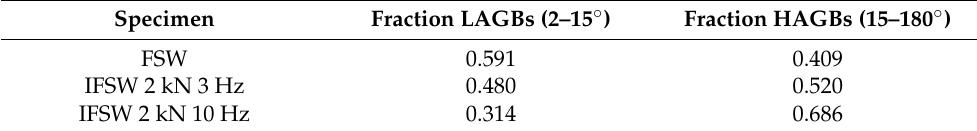
Table 3. Fraction of the LAGBs and HAGBs defined in the Stir Zone of the studied joints.